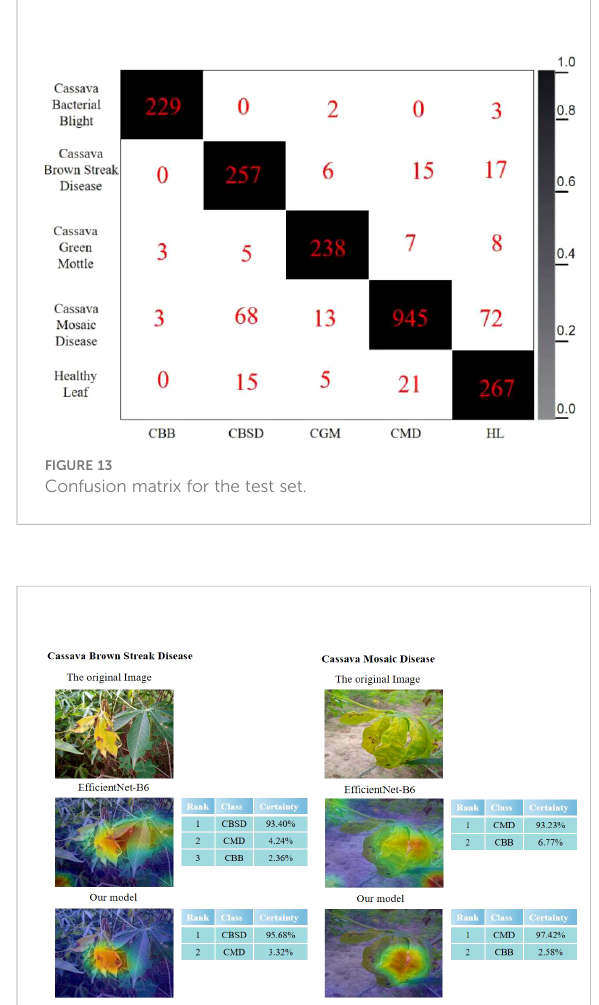
FIGURE 14 Visual comparison of Ef fi cientNet-B6 and our